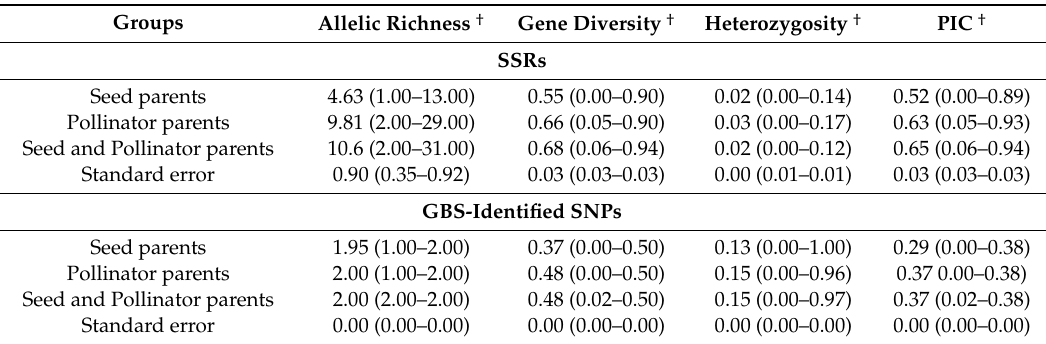
Table 1. Average of allelic richness, major allele frequency, gene diversity, heterozygosity and polymorphism information content (PIC) of the 52 SSRs and 7870 GBS-identified SNPs in hybrid parents of forage pearl